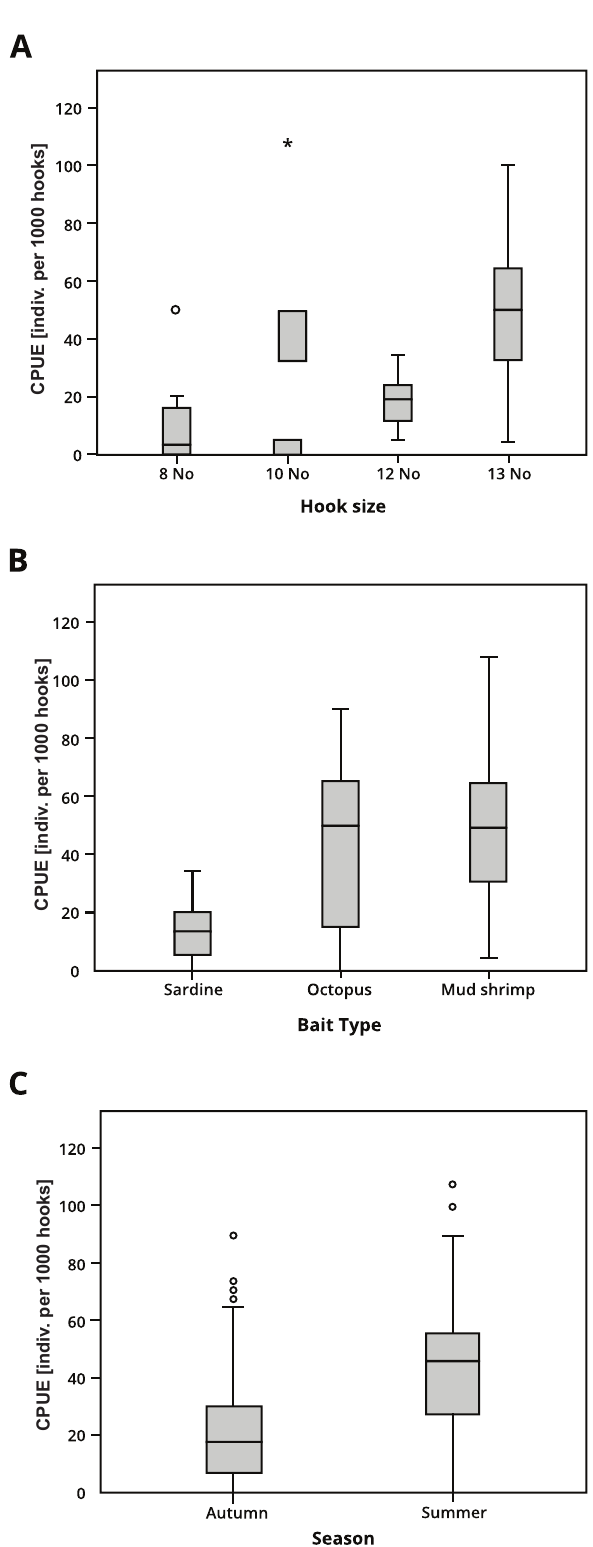
Fig. 3. CPUE of all fish related to ( A ) hook size, ( B ) bait type, and ( C )